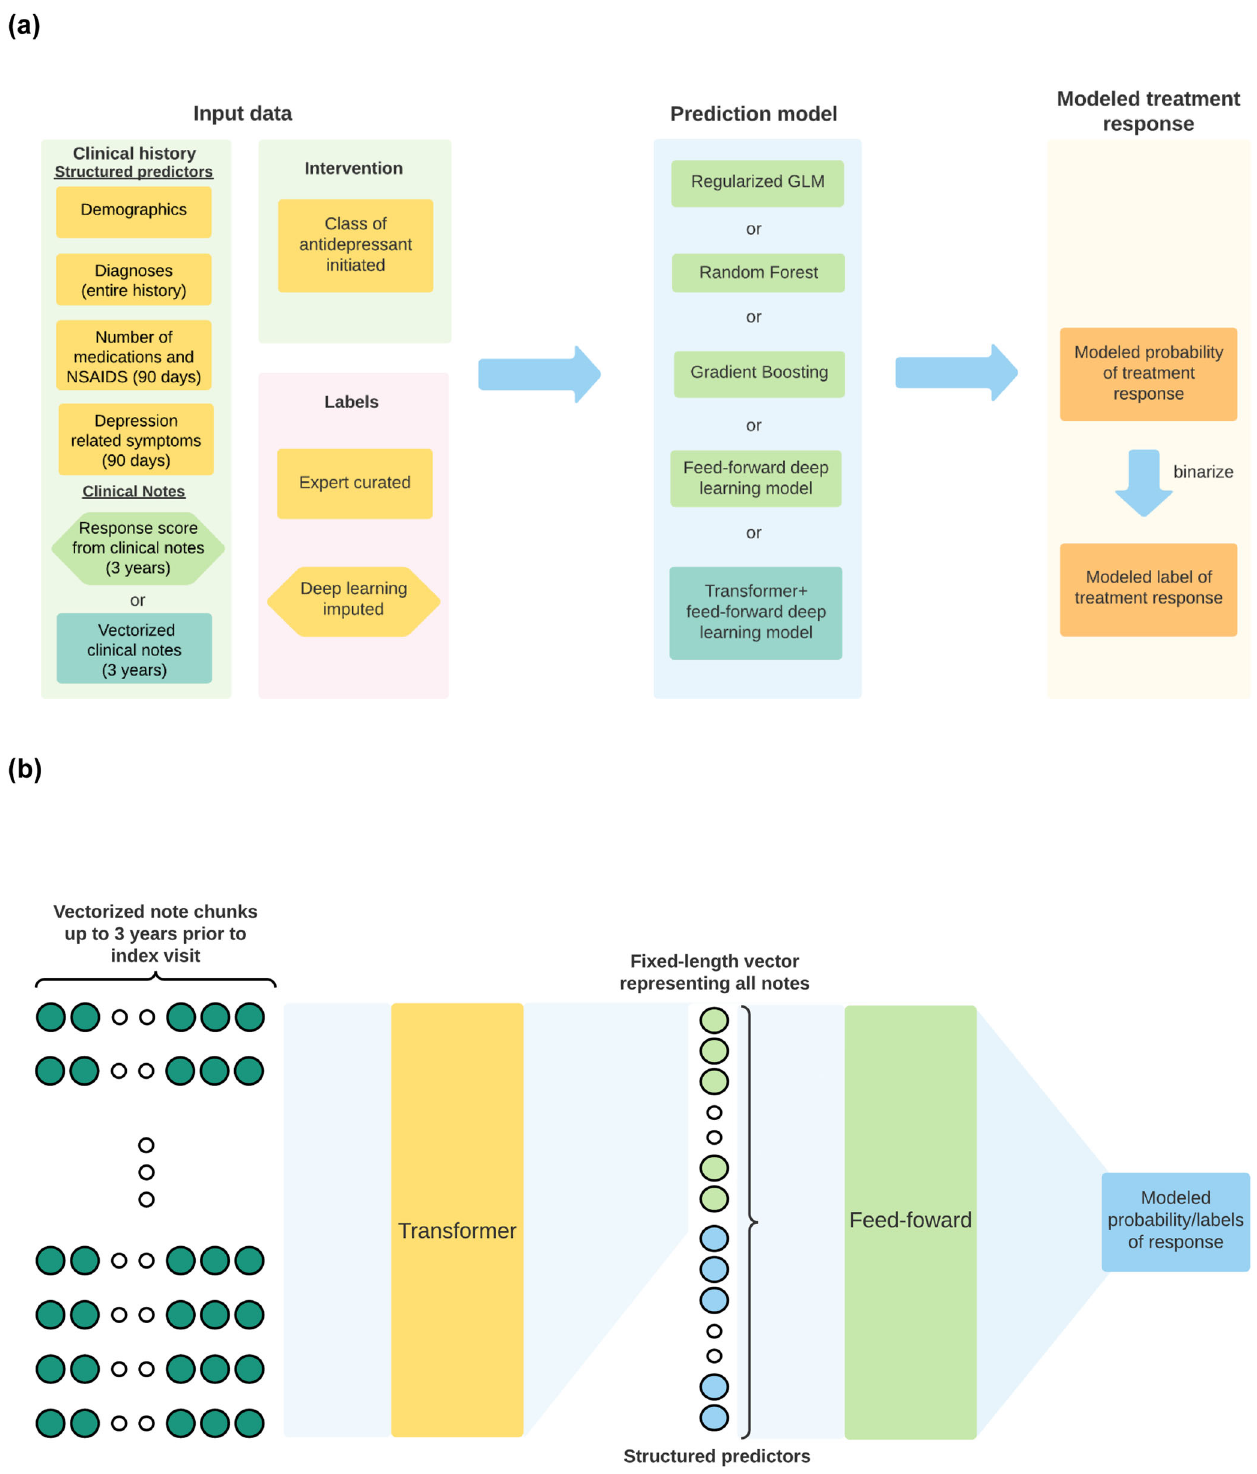
Fig. 4 Diagrams for prediction modeling designs. a Schematic diagram for modeling antidepressant treatment response (improved vs no evidence for improvement). Model inputs comprised structured and unstructured EHR data regarding demographics and clinical history, choice of antidepressant class, and response outcome labels. Labels were based on chart review by a psychiatrist, plus in some cases by deep learning imputed labels as described in the text. Prediction model outputs modeled probabilities of treatment response, which can be further binarized to a modeled improvement (yes/no) label. Hexagonal boxes indicate data components that were experimentally evaluated for their effect on prediction performance. Yellow boxes indicate data that are used as inputs for every model. Light green and cyan boxes are inputs used only with prediction models shown in matching colors. b Schematic diagram for the Transformer + feed-forward DNN model. The model fi rst takes in the vectorized clinical notes through the Transformer, transforms them into a fi xed-sized vector, which is concatenated with the other features and then passed through additional feed-forward